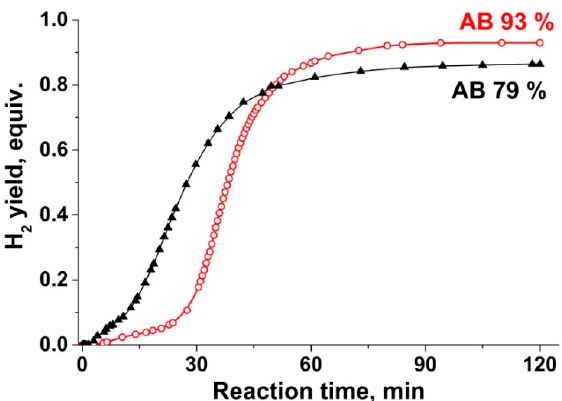
Figure 1. Release of hydrogen from samples of NH 3 BH 3 having different purities. Temperature is 100 ° C, and the amount of the sample is 100 mg.